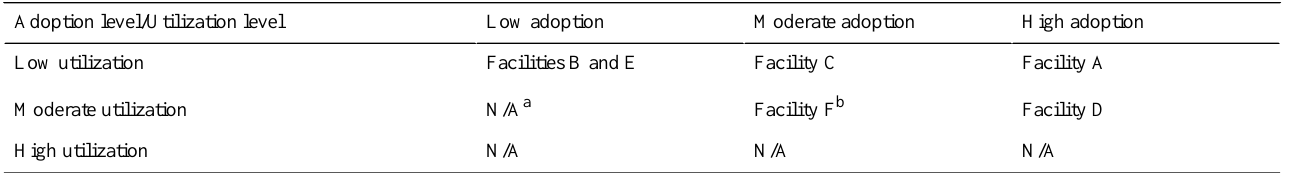
Table 1. Adoption and utilization per health facility.